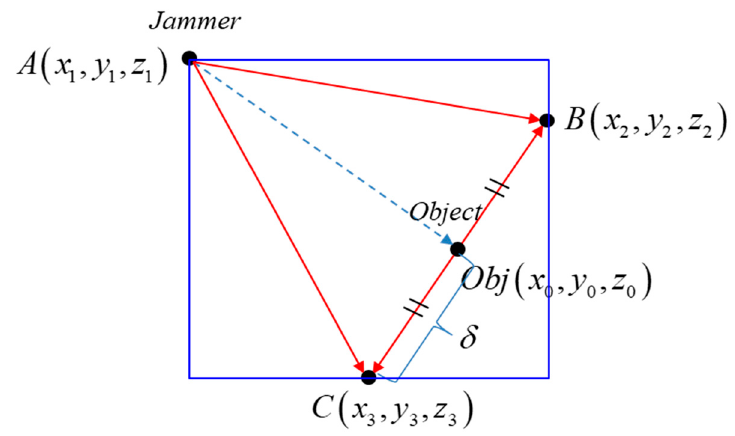
Figure 4. Line-of-sight (LOS) decision triangle and its bounding box.